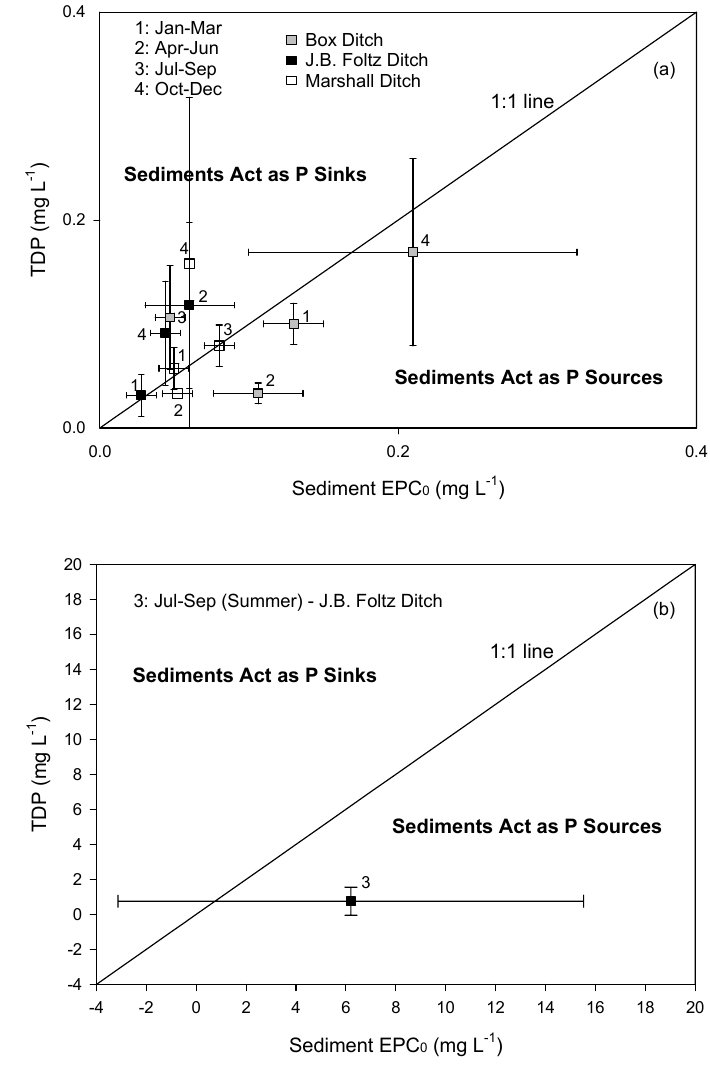
Figure 2. Comparison of sediment EPC 0 and water column TDP concentrations showing that sediments acted as sinks or sources of P or were in equilibrium with the overlying water column. The whiskers represent standard deviation from the measured